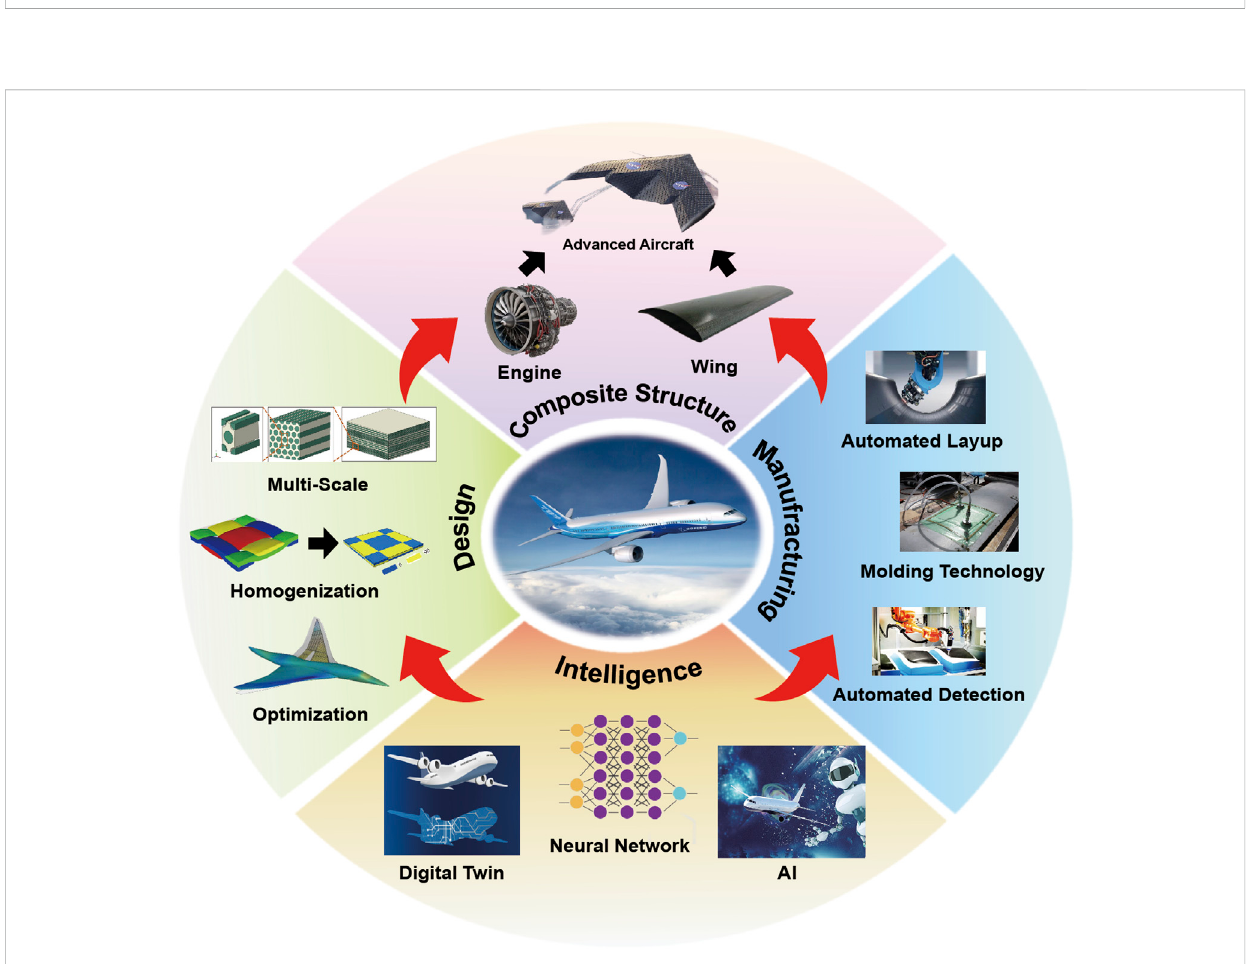
FIGURE 2 Development of design and manufacturing technologies of composite structures with